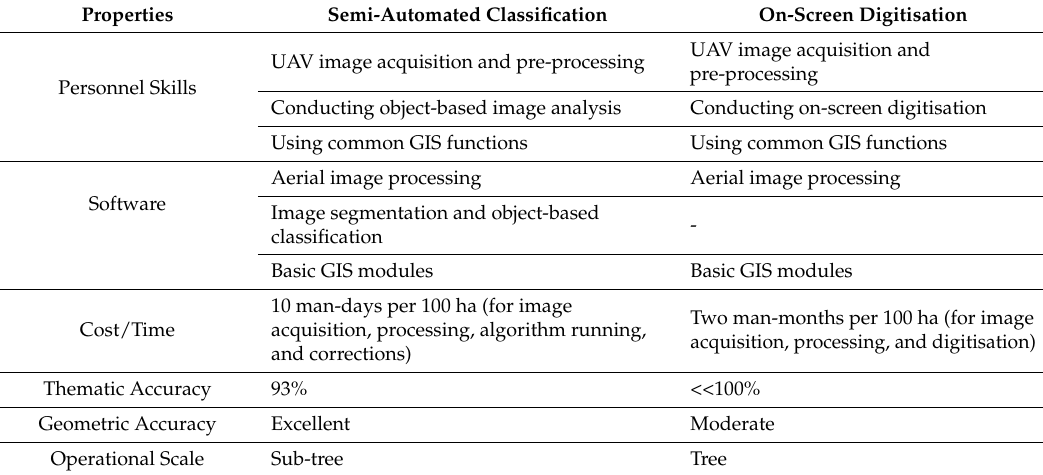
Table 2. Requirements and performance of the proposed processing chain compared to on-screen